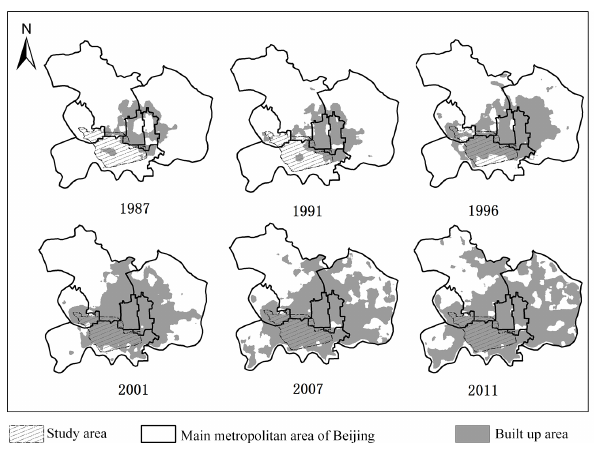
Figure 2. Urbanization processes in the Dahongmen